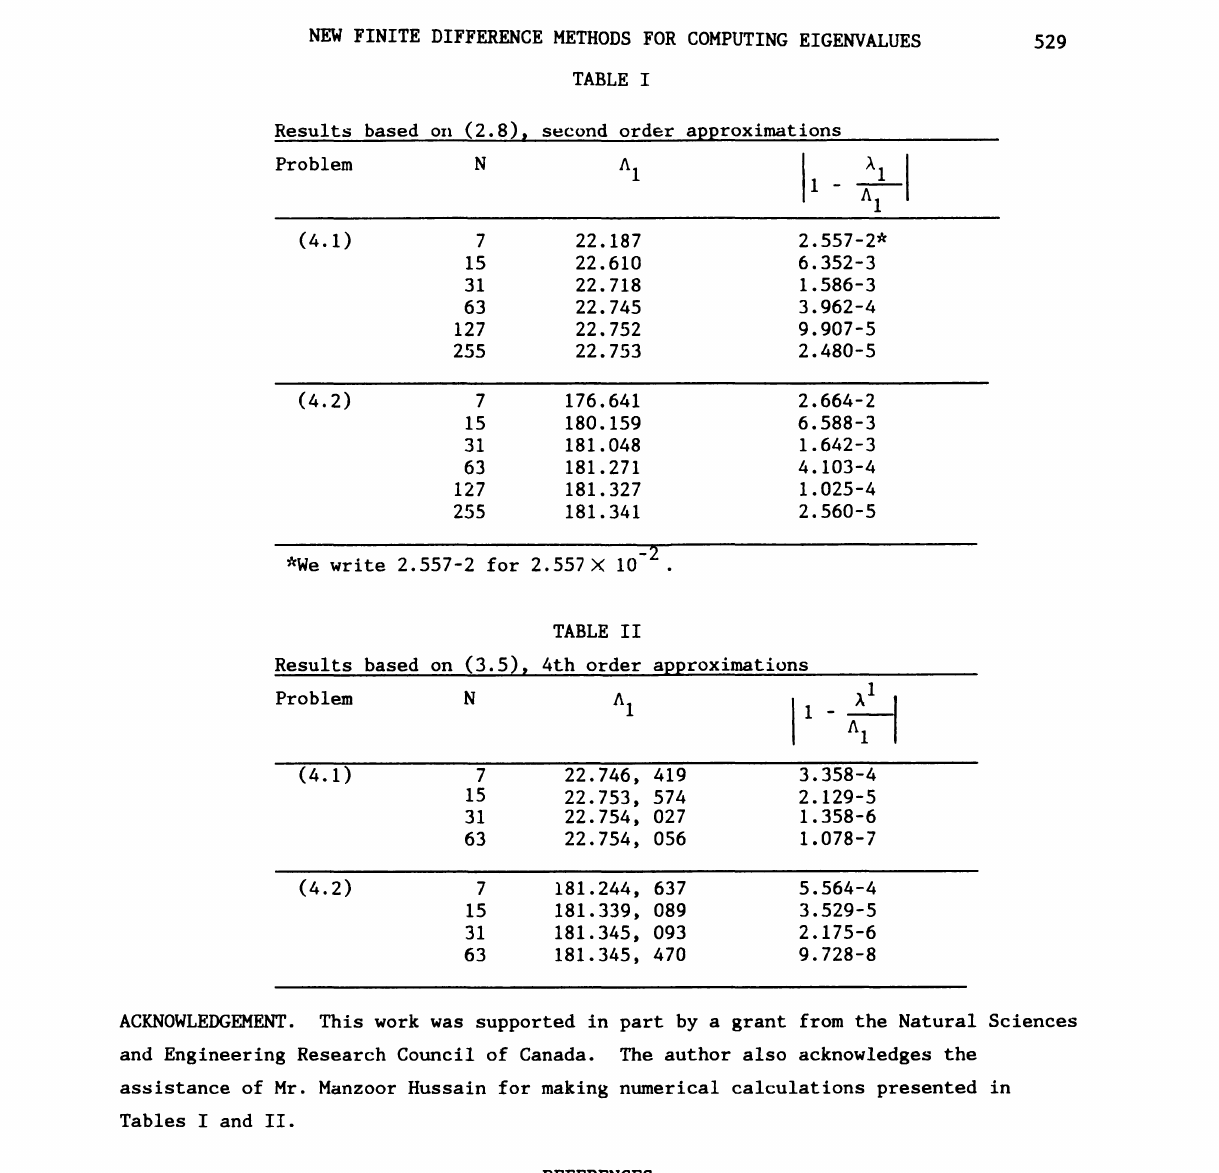
Results based on (2.8) second order approximations